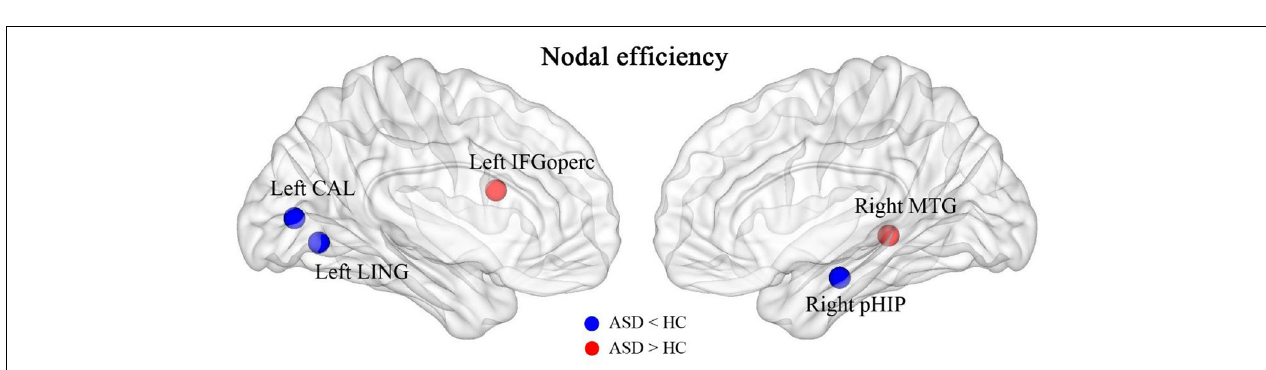
FIGURE 5 | Clustering coefficients and local efficacy of the abnormally elevated network FC in ASD. Red * indicates that the network attributes of the two groups are significantly different under this threshold ( p < 0.05). The histogram represents the area under the curves of the two groups. The black star indicates that there are significant differences in the AUC values of the two groups’ network attributes. ns, no